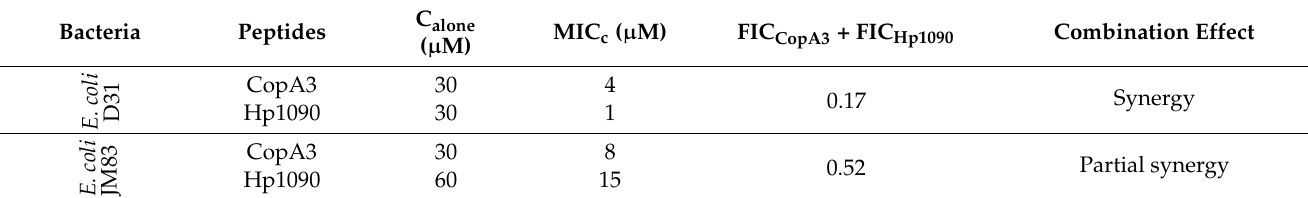
Figure 6. The combined effect of CopA3 and Hp1090 against two E. coli strains. The combined antibacterial activity of the parental AMPs was tested against E. coli D31 ( A , B ) and E. coli JM83 ( C , D ). ( A , C ) The sublethal concentration of CopA3 was set at 15 µ M and was combined with increasing concentrations of Hp1090. ( B ) The sublethal concentration of Hp1090 was set at 15 µ M and was combined with increasing concentrations of CopA3. ( D ) The sublethal concentration of Hp1090 was set at 30 µ M and was combined with increasing concentrations of CopA3. The AMP with the constant concentration is marked with an asterisk. The OD 600 was recorded using a microtiter plate reader. In each panel, the red line indicates the total inhibition of the combined treatment, the gray line shows the decreasing concentration of the serially-diluted AMP with the other sublethal concentration and the black line shows the bacterial growth curve in the absence of AMPs. Table 2. The fractional inhibitory concentration index (FIC index ) of the combined treatment with parental AMPs CopA3 and Hp1090 against E. coli strains D31 and